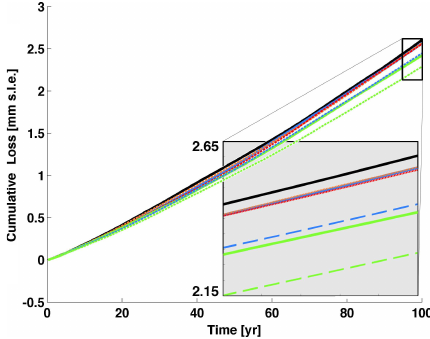
Fig. 3. Additional mass loss from changes in surface mass balance for the MarAsl2 experiment initiated from IS with respect to a con- trol run. This mass loss component increases almost linearly and higher-order dynamics reduce the